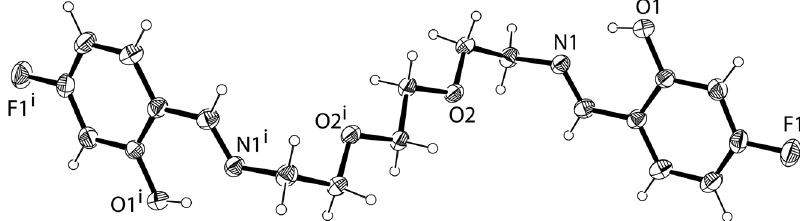
Table  : Data collection and